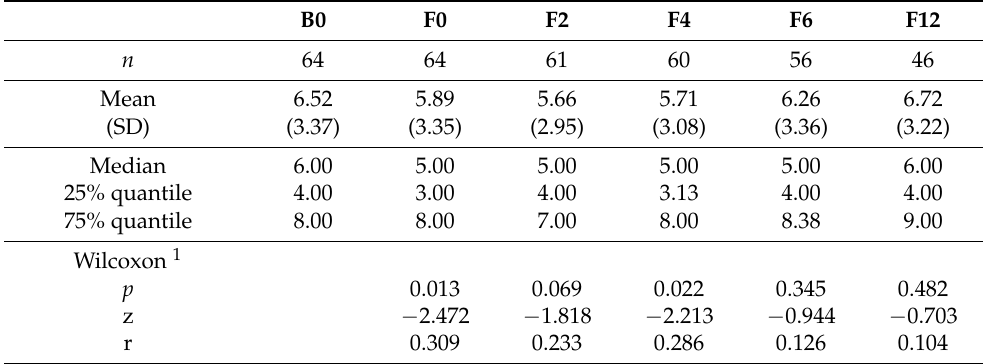
Table A5. Sedentary time per day in hours.